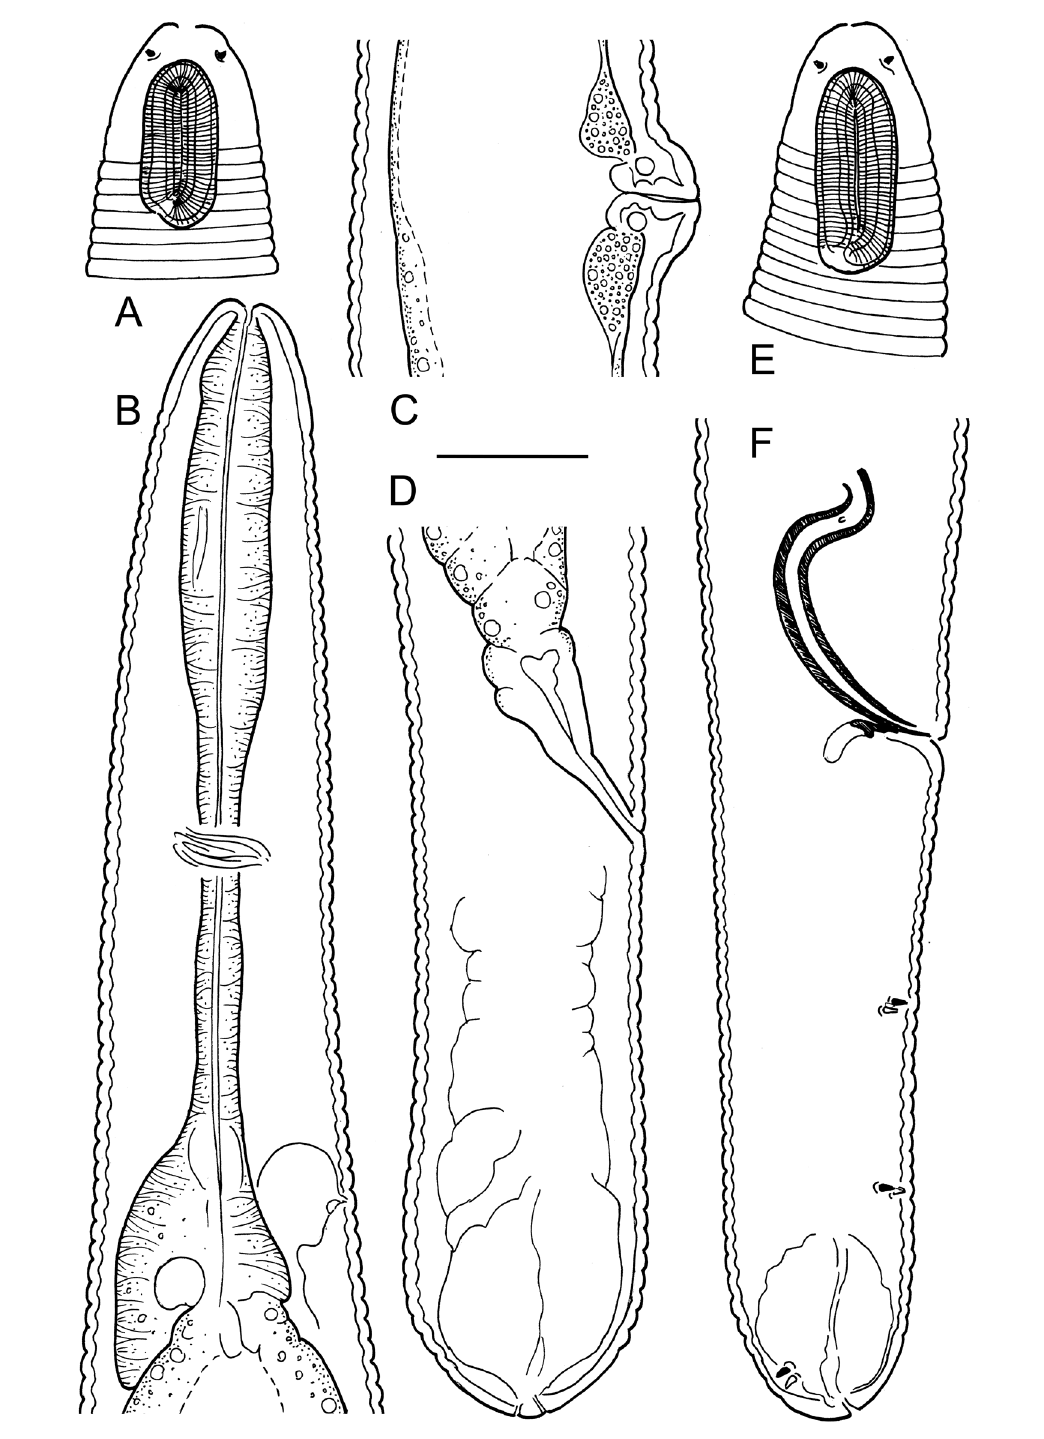
Fig. 5. Diplopeltoides bulbosus (Vitiello, 1972) comb. nov. A . Female anterior end, surface view. B . Female pharyngeal region, optical median section. C . Vulval region. D . Female tail. E . Male anterior end, surface view. F . Male tail. Scale bar = 20